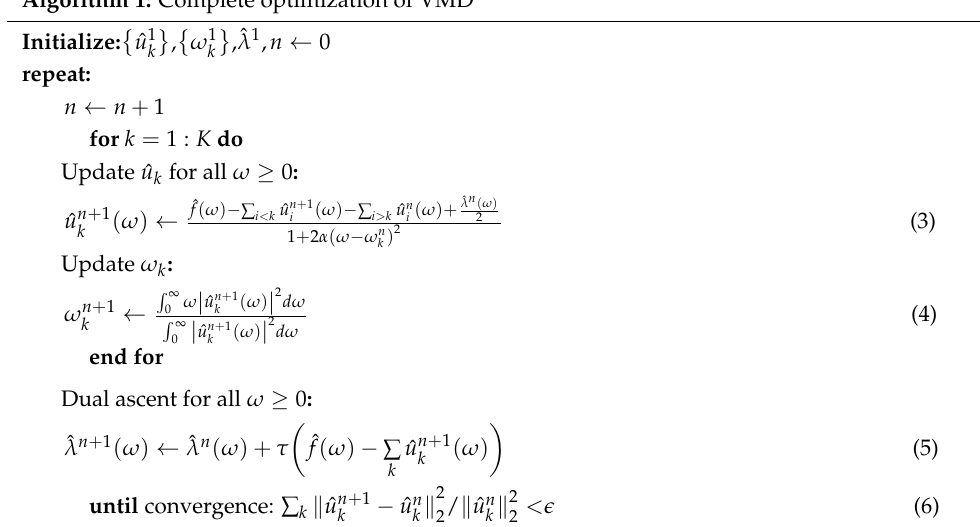
Algorithm 1: Complete optimization of